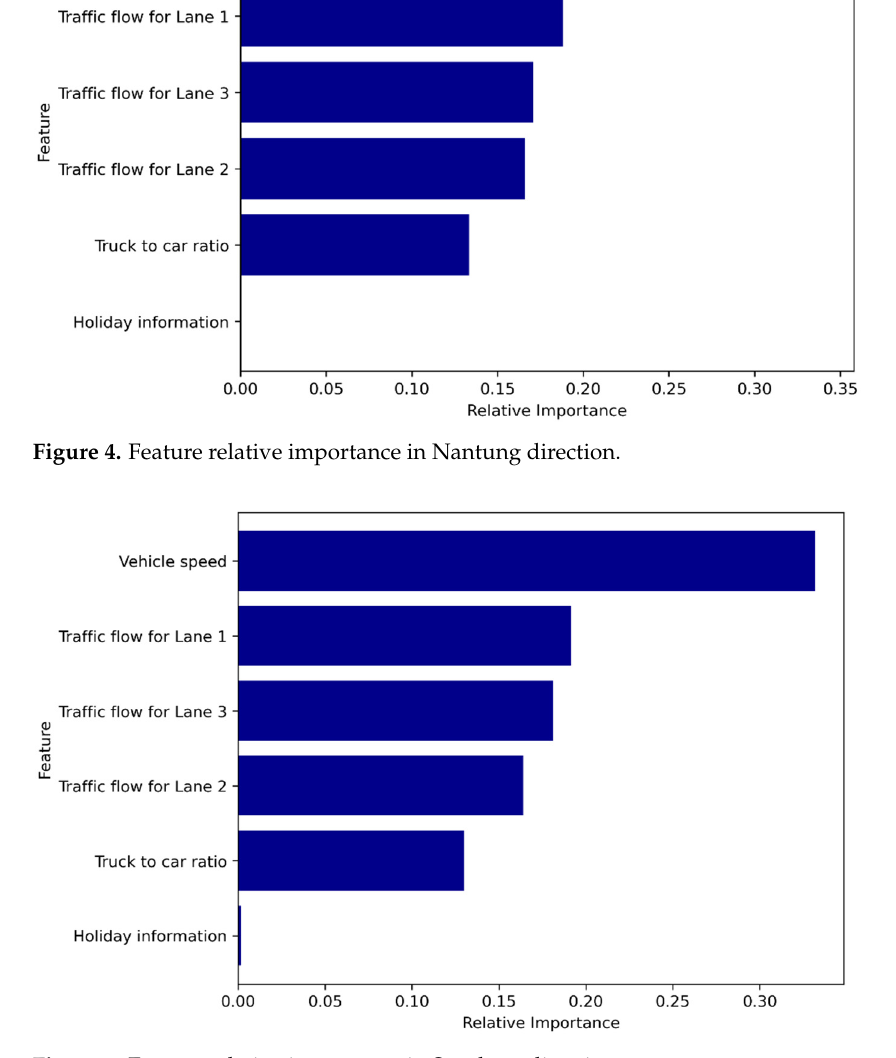
Figure 7. Feature relative importance in Soochow direction.